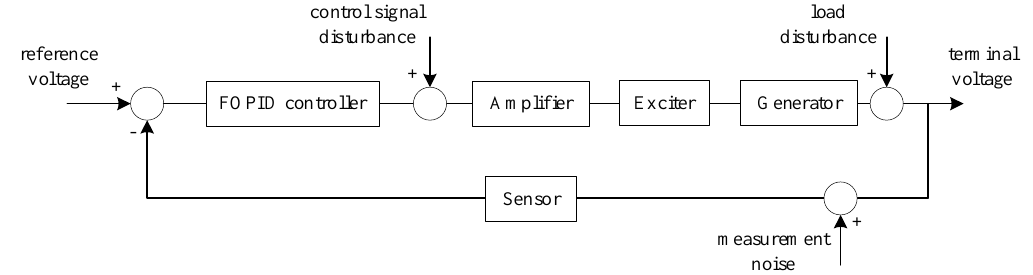
Figure 17. Block diagram of the AVR system considering different kinds of disturbances.